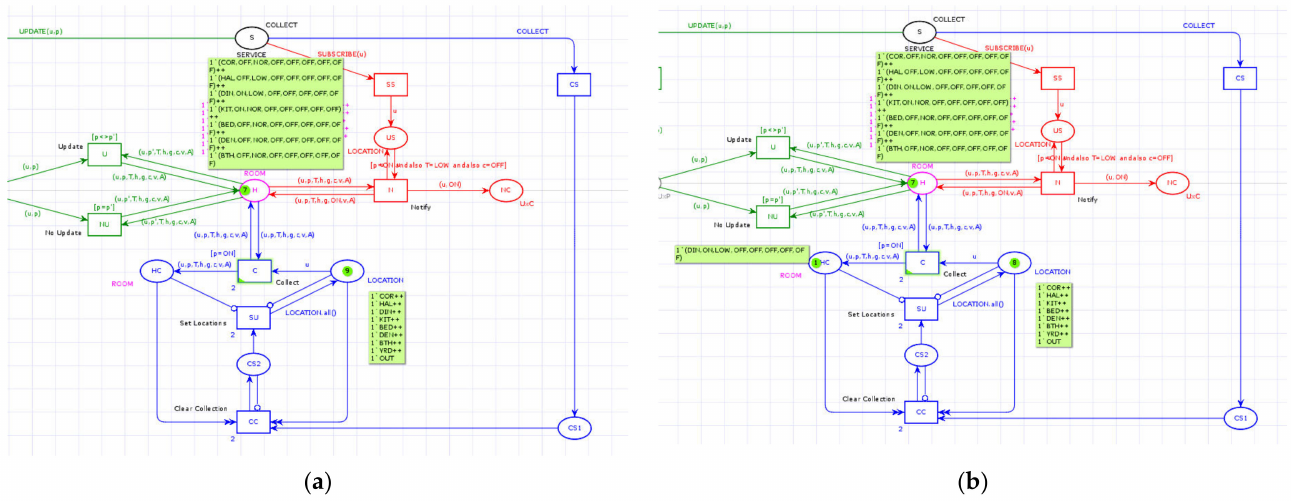
Figure 4. Subscription for collection service behavior. In ( a ), transition C is enabled by the marking. In ( b ), a notification for each subscriber found in place U has been deposited in place